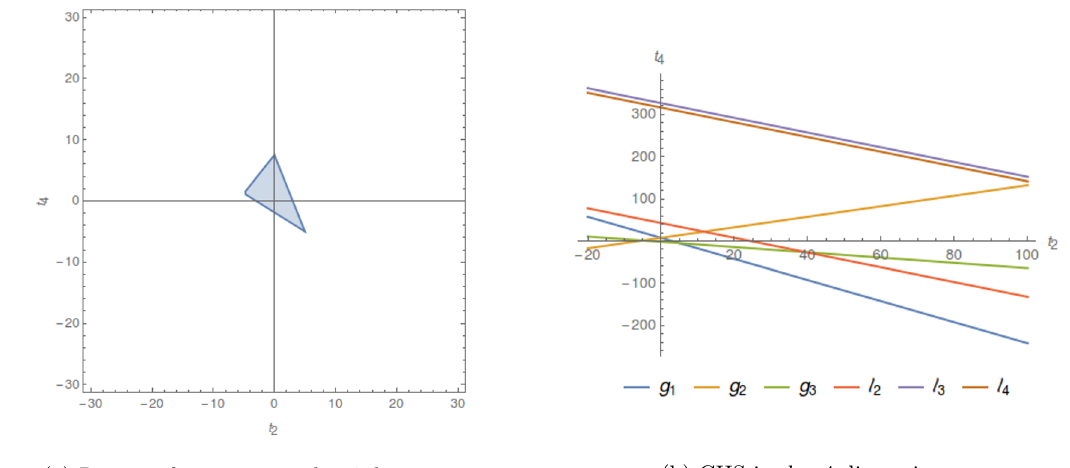
Figure 5. The region of unitarity is the small triangle where g 1 , g 2 and g 3 meet near the origin. The region near the origin is shown clearly in the left